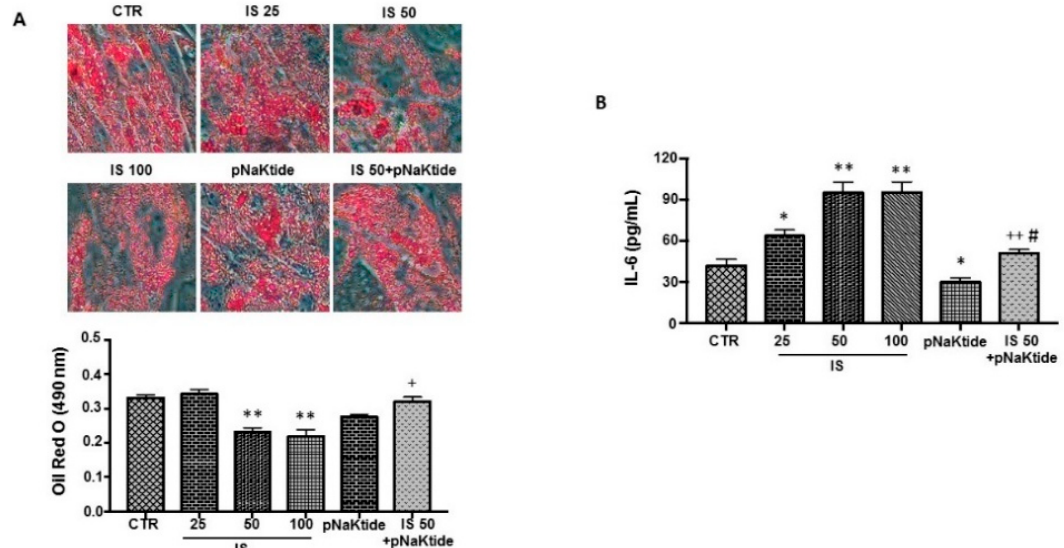
Figure 5. MSC-derived adipocytes exposed to varying concentrations of IS (25, 50 and 100 µ M) and treated with or without pNaKtide: ( A ) Representative images and quantitative data of adipogenesis measured as the relative absorbance of Oil Red O. Images taken with 40 × objective lens; and ( B ) quantitative analysis of pro-inflammatory cytokine IL-6. Values represent means ± SEM ( n = 4). * p < 0.05 vs. CTR, ** p < 0.01 vs. CTR, + p < 0.05 vs. IS 50 µ M, ++ p < 0.01 vs. IS 50 µ M, # p < 0.05 vs. pNaKtide.